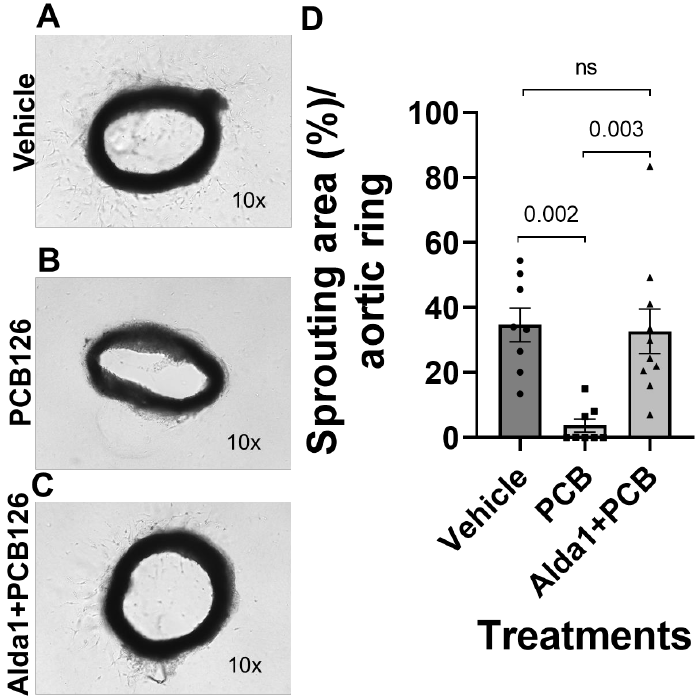
Figure 7. ( A – C ) Representative micrographs of sprout formation by the vehicle, 4.4 µM PCB126, and 10 µ M Alda1 + 4.4 µ M PCB126-treated aortic rings on the collagen matrix for 72 h, respectively. Magnification: 10×. ( D ) Quantitative data of the sprouting area/aortic ring with different treatments stated in ( A – C ). n = 8 – 10 for each group. Each bar represents the mean ± SEM. PCB, polychlorinated biphenyl; ns, not significant.